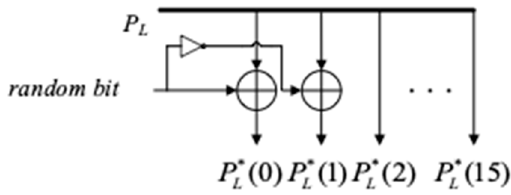
Figure 10. The structure of fault introducing circuit.